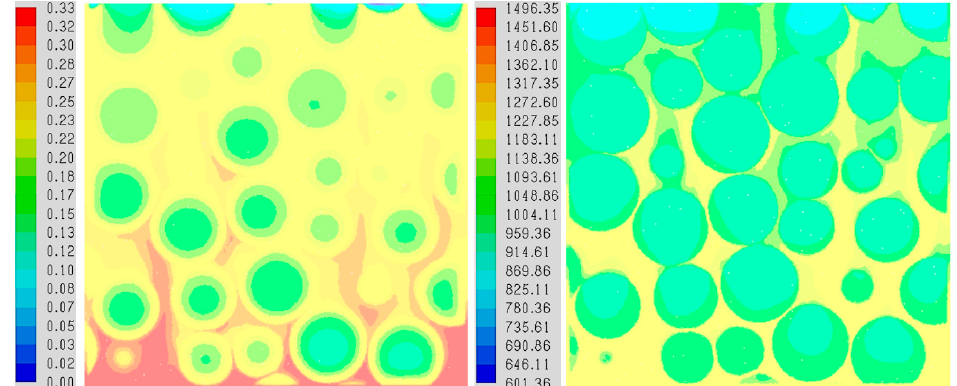
Figure 2. Particle resolved direct numerical simulation (PR-DNS) results for molar concentration of CH 4 ( left ); and gas temperature (K) variation at 1000 °C (1273 K) inlet temperature ( right ).